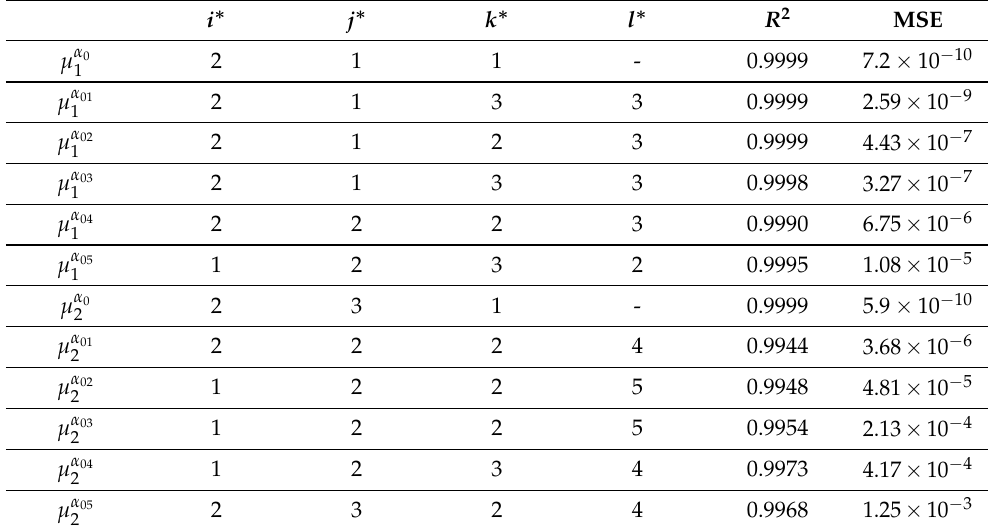
Table 3. Grades of the best fits, R 2 coefficients and